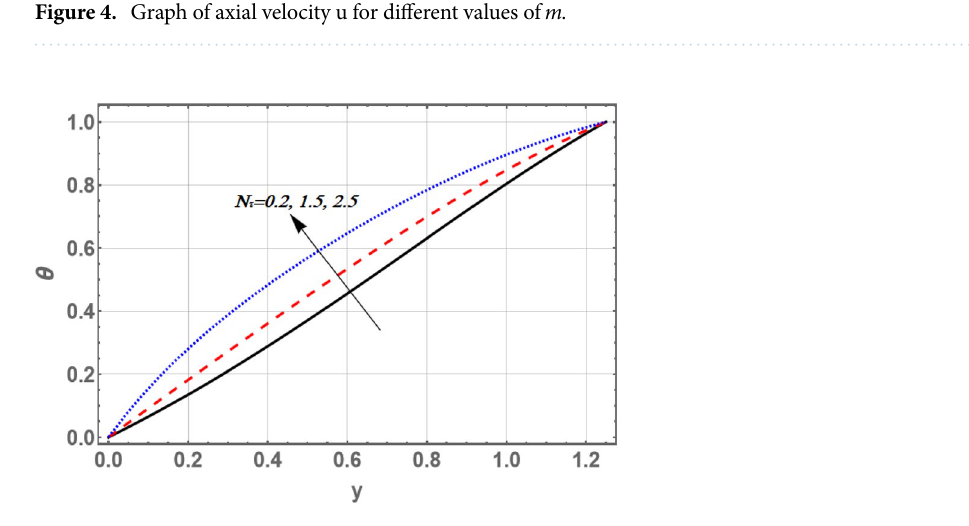
Figure 5. Graph of temperature θ for different values of Nt